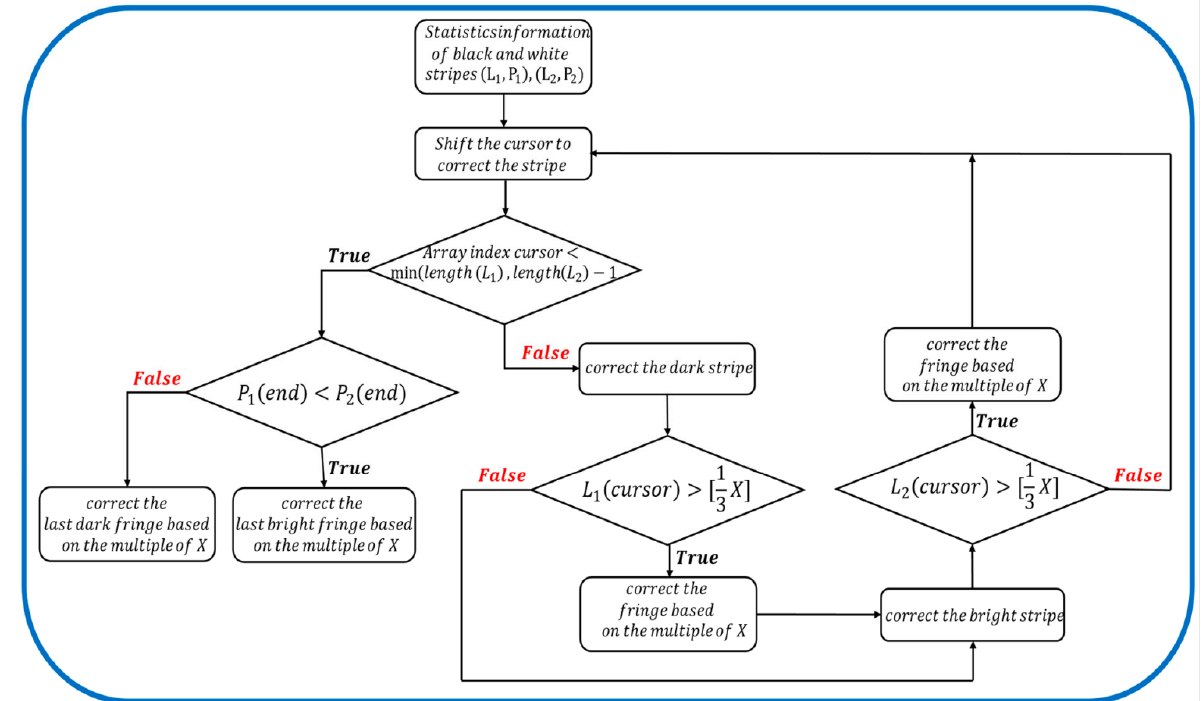
Figure 3. Flow diagram of the proposed BFC